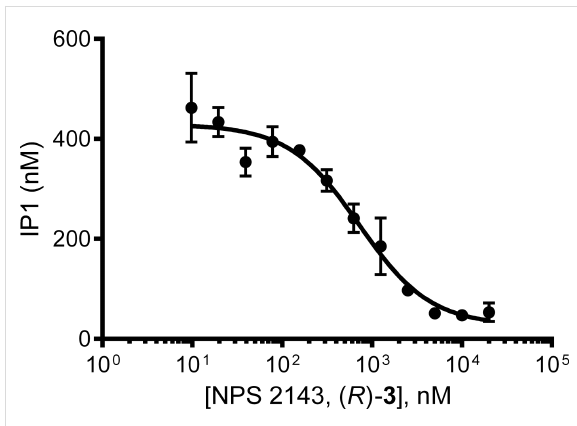
Figure 3: Characterisation of concentration-dependent ( R )- 3 inhibition of 3.5 mM calcium-stimulated IP 1 response in HEK293 cells stably transfected with rat CaSR. The graph is representative of three inde- pendent